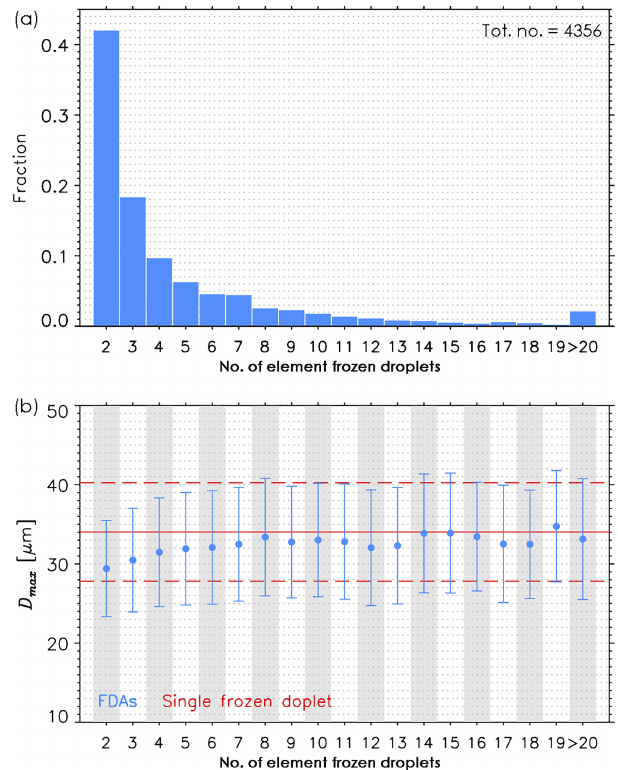
Figure 6. (a) Normalized frequency of occurrence of the number of component frozen droplets within 4356 FDAs analyzed. (b) The average and standard deviation of the diameter of frozen droplets as a function of number of component frozen droplets within FDAs (blue). The average (red solid line) and standard deviation (red dash line) of the D max of single frozen droplets are also